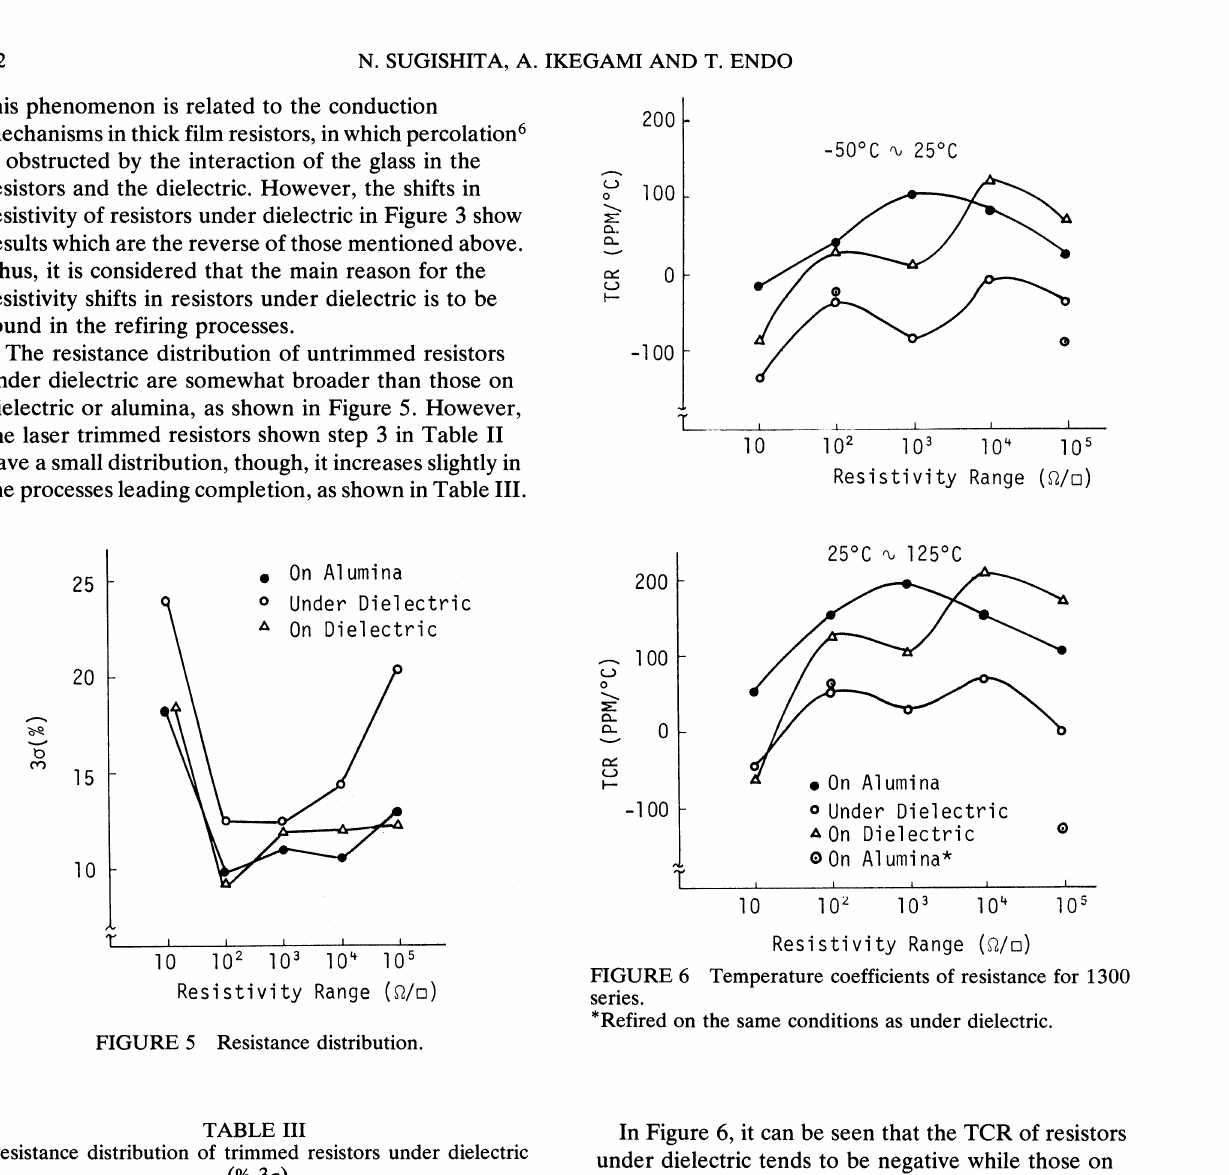
TABLE III Resistance distribution of trimmed resistors under